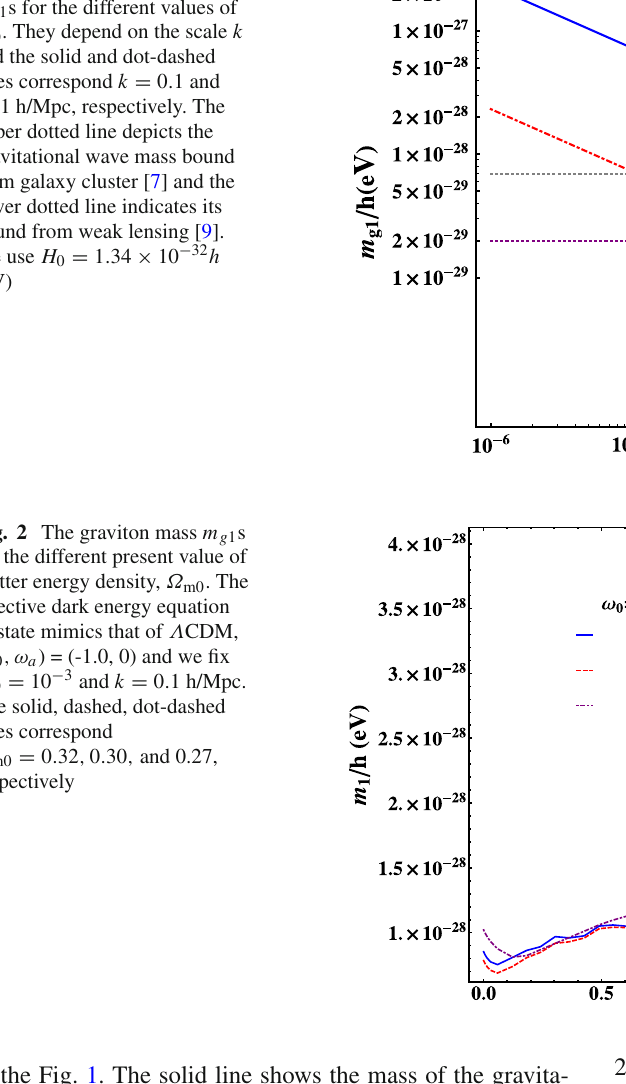
Fig. 2 The graviton mass m g 1 s for the different present value of matter energy density, Ω m0 . The effective dark energy equation of state mimics that of Λ CDM, ( ω 0 ,ω a ) = (-1.0, 0) and we fix M 0 = 10 − 3 and k = 0 . 1 h/Mpc. The solid, dashed, dot-dashed lines correspond Ω = 0 . 32 , 0 . 30 , and m0